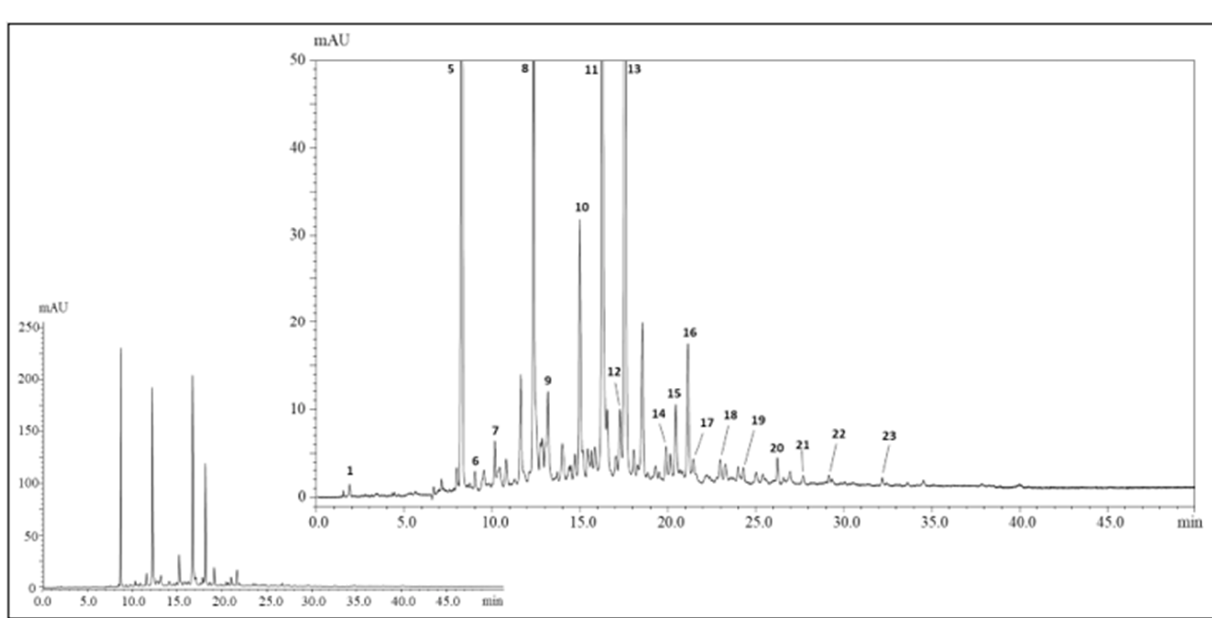
Figure 3. Profile of polyphenolic compounds in the aqueous extract of dried calyces of H.s. ( λ = 280 nm). The inset illustrates the unzoomed chromatogram. Table 1. Identification of the available polyphenolic compounds in the extract of H.s. during simulated human digestion. x indicates the presence of the compound in the H.s . extract.—indicates absence of the compound in the extract.